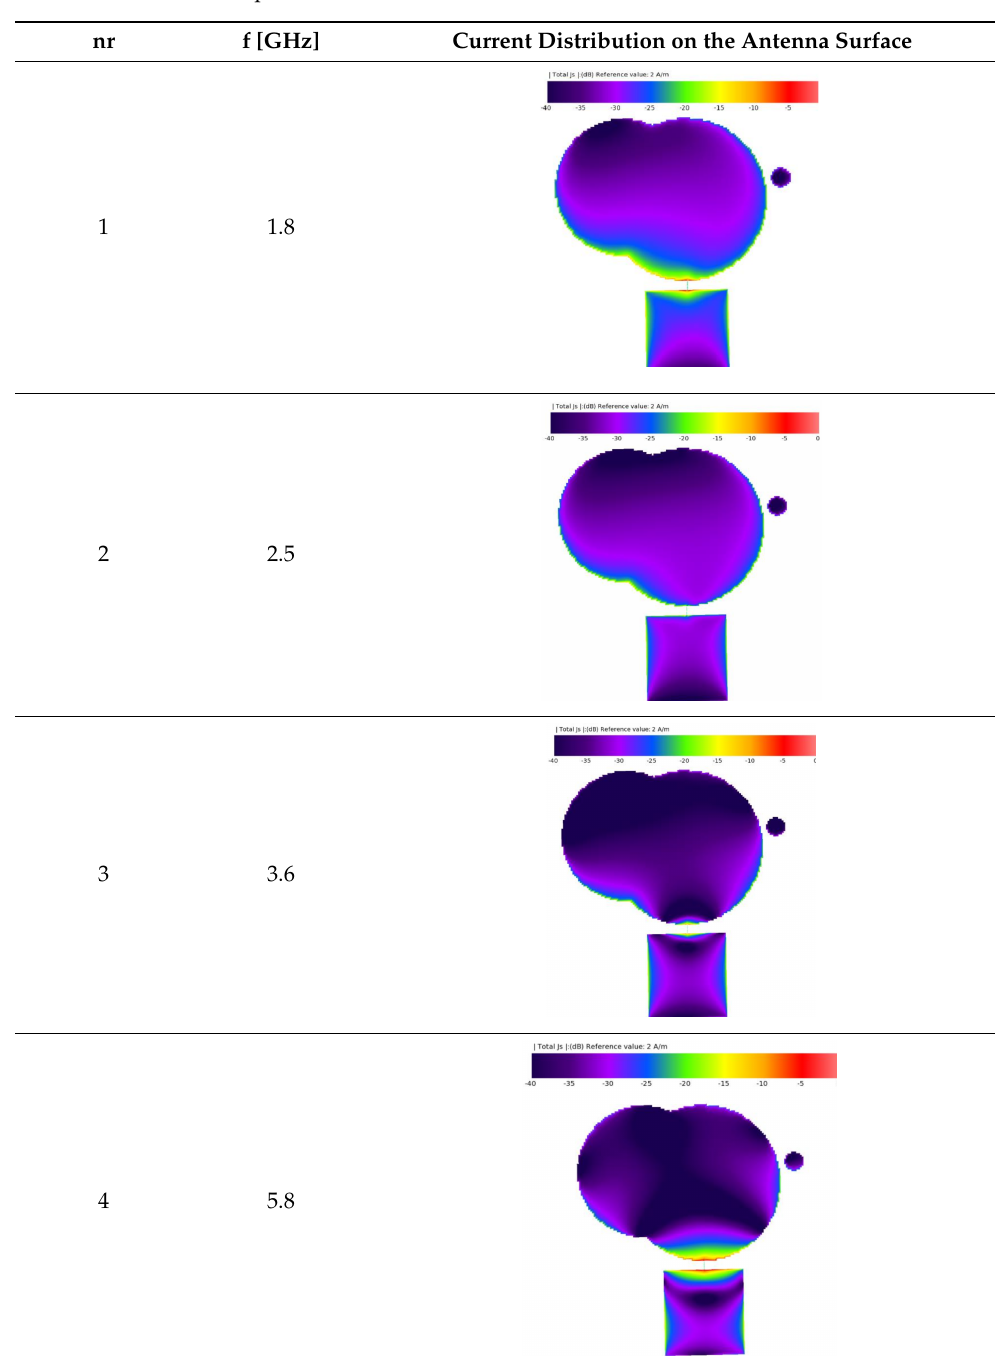
Table 7. Parameters of optimized three circle